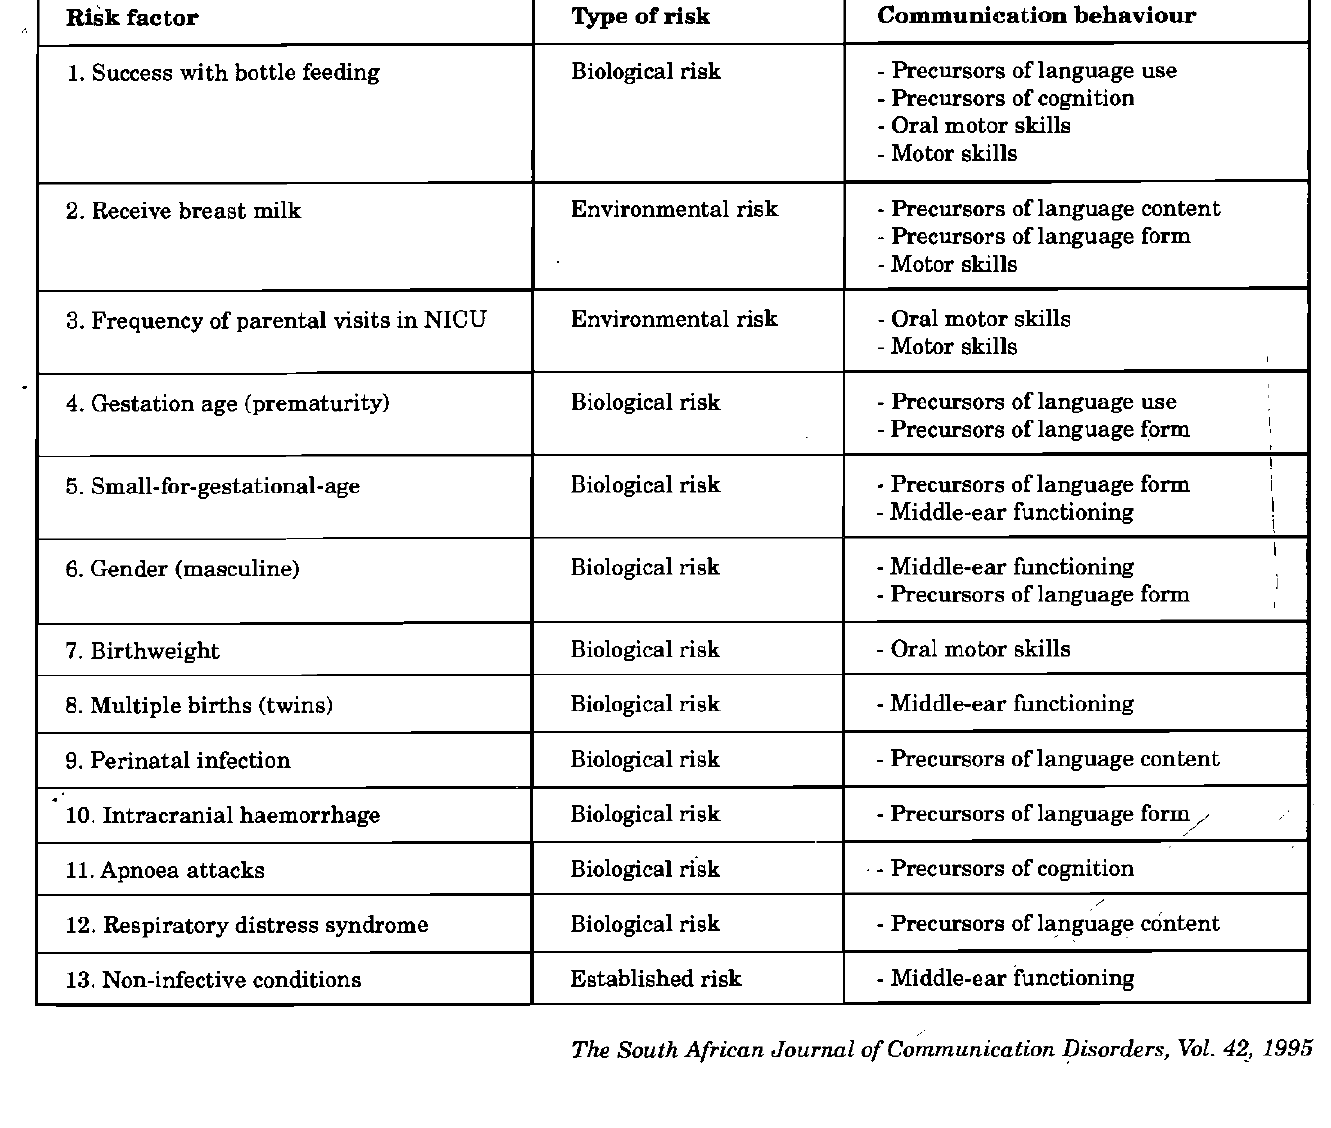
Table 3: Significant risk factors of communication development in order of predictability, N=50 Risk